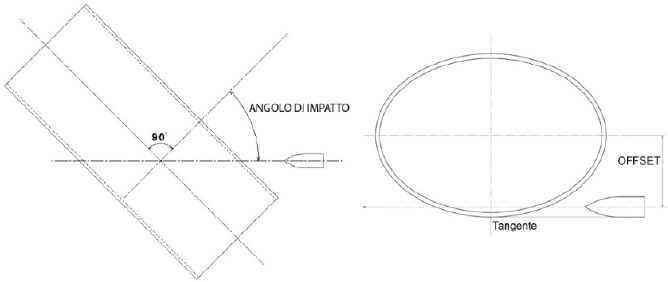
Figura 2: Parametri che definiscono le condizioni di impatto.